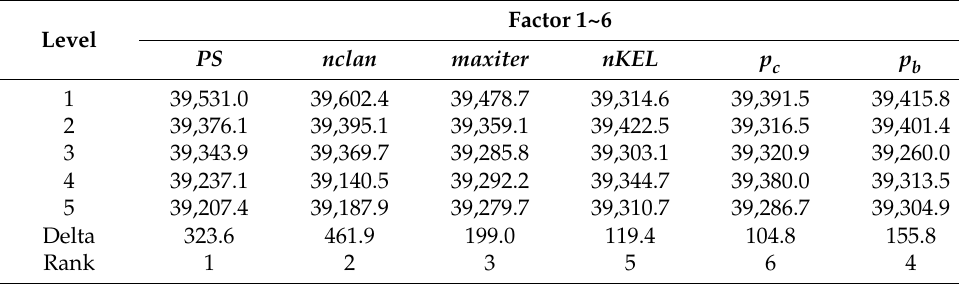
Table 5. Response value and significance